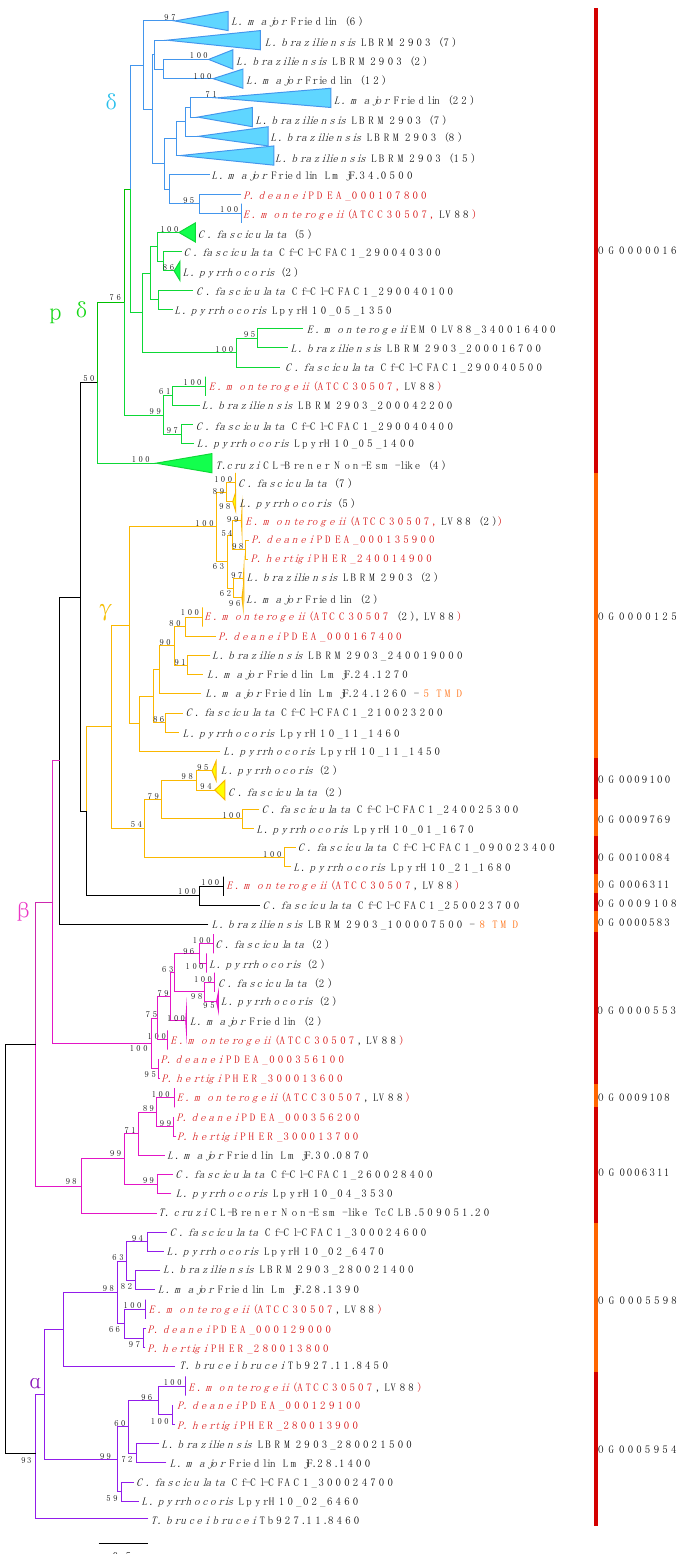
Figure 2. Maximum-likelihood phylogenetic tree of 188 kinetoplastid amastins. Only bootstrap supports over 50% are shown. The sequences obtained in this study are shown in red with the respective OG IDs. The five classes of amastins are highlighted in different colors. Most analyzed proteins have four transmembrane domains (TMDs), with a few exceptions indicated in the tree and Table S12. Numbers of sequences within collapsed clades are shown in brackets.